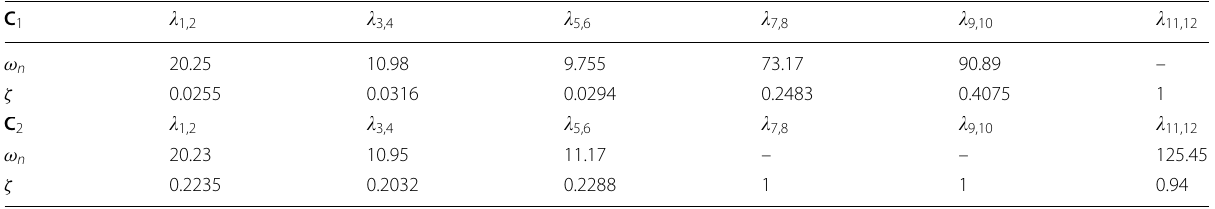
Data from all six pairs of eigenvalues in the modal space are